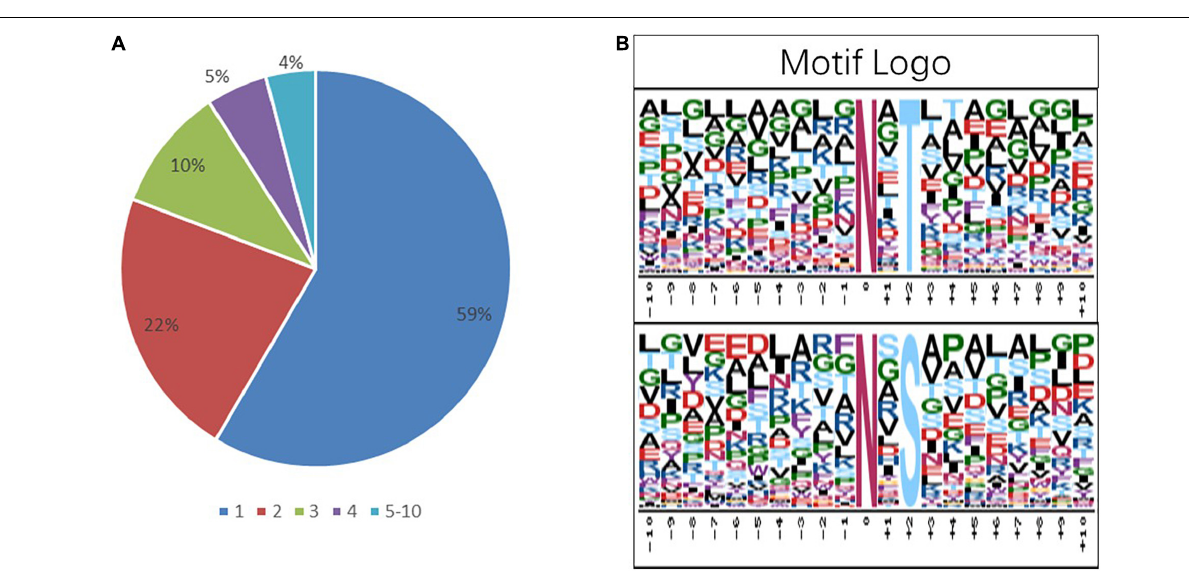
FIGURE 4 | Analysis of the characters of the identified peptides. sequence motifs of the N-glycoproteome data. (A) The proportion of the protein containing one or more glycosylation sites in the total glycoprotein; the sector refers to the ratio of each category N-glycoprotein accounting for all N-glycoproteins. (B) The distribution of amino acids from − 10 position to +10 position of motif N–X–S and motif N–X–T; the central N (at position 0) indicates the